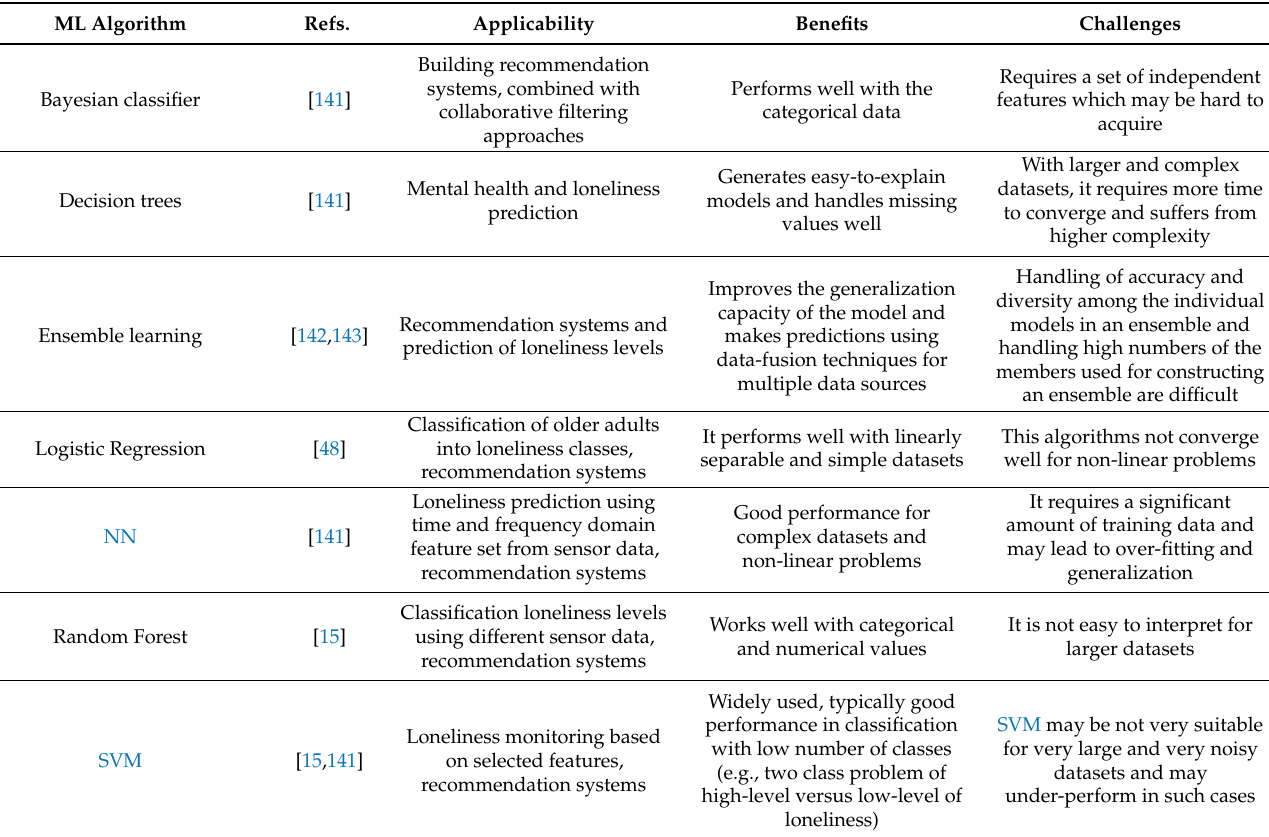
Table 5. Summary of relevant ML algorithms and their applicability for loneliness measuring and